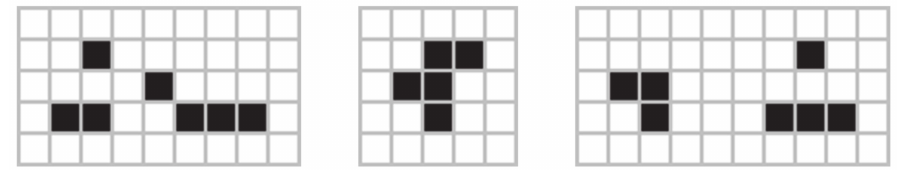
Figure 8. Some well-known Methuselahs; Left to right: (a) acorn, (b) r-pentonimo, (c) diehard, as shown in Reference [74].